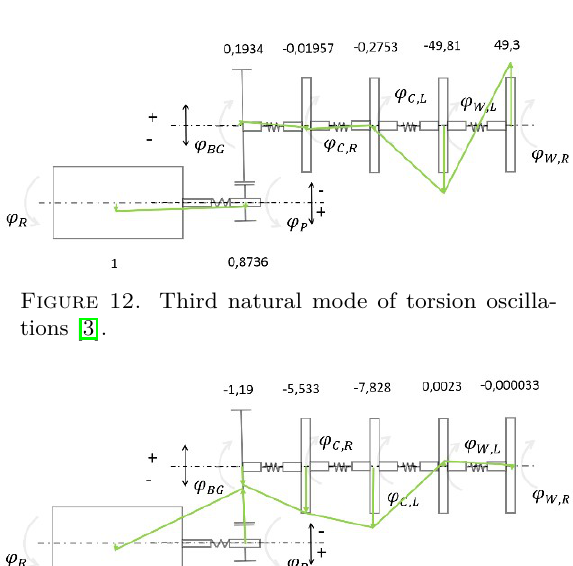
Table 2. Description of natural modes [3].